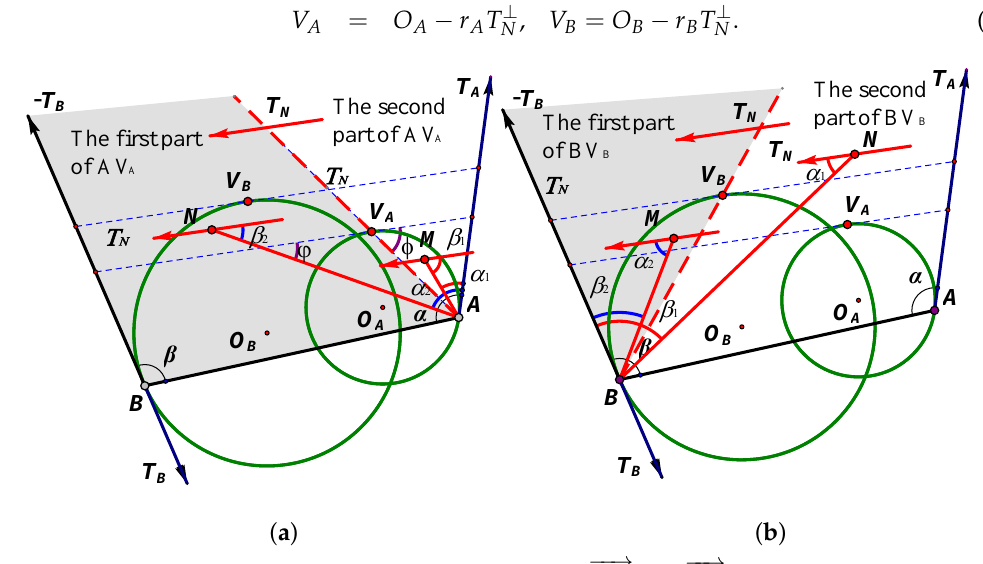
Figure 5. The first (grayed region) and second part of ( a ) Divide region G into